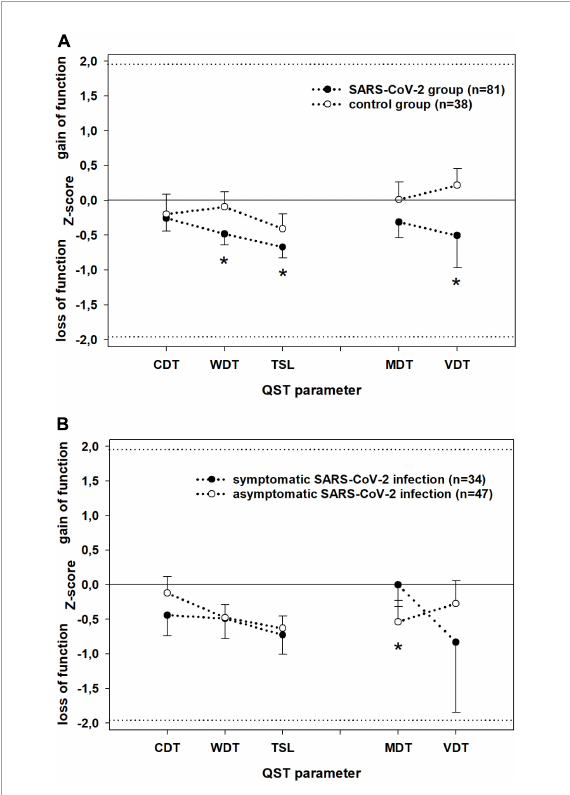
FIGURE2 Detection thresholds at dorsal feet (z-score; mean ± SD) assessed by Quantitative Sensory Testing in (A) patients (black) vs. controls (white) and (B) patients with symptomatic (black) vs. patients with asymptomatic (white) SARS-CoV-2 infection. Parameters assessing the small (WDT; CDT; TSL) and large (VDT, MDT) fibre function have been separately linked by dotted lines for better visualisation. Z -values between –1.96 and 1.96: normal range of healthy subjects. Z -values > 0: gain of sensory function, z -values < 0: loss of sensory function. CDT, cold detection threshold; WDT, warm detection threshold; TSL, thermal sensory limen; MDT, mechanical detection threshold; VDT, vibration detection threshold. Significant differences ( P < 0.05) are marked with